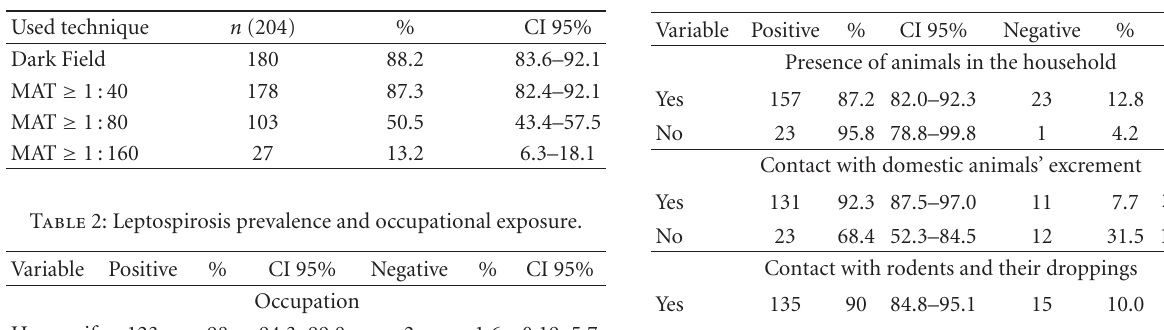
Table 1: Leptospirosis prevalence by means of 2 diagnostic techniques.